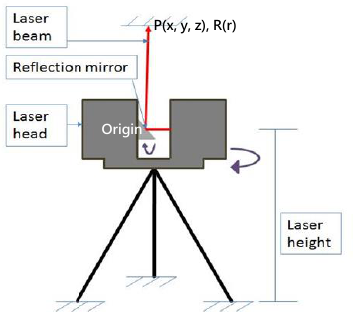
Figure 2. The LiDAR scanning and data point representation Visual inspection and LiDAR bridge inspection both fall into the ‘field bridge inspection’ and the ‘data processing’ processes as defined in the DOT’s bridge inspection workflow. Visual